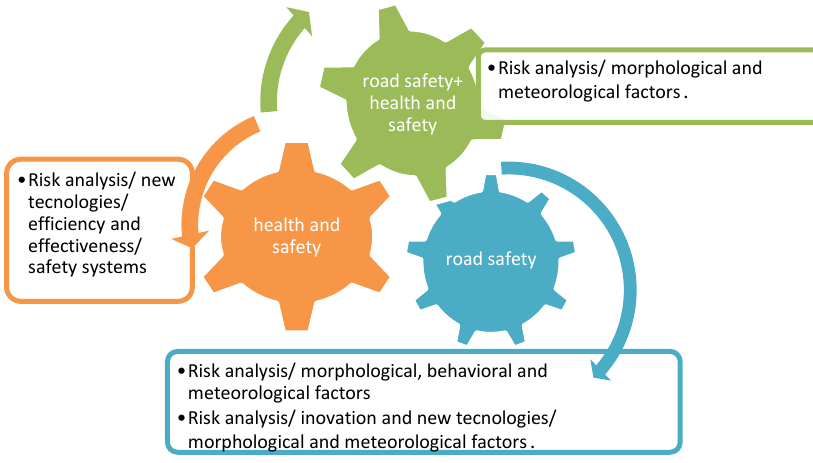
Figure 1. Research themes